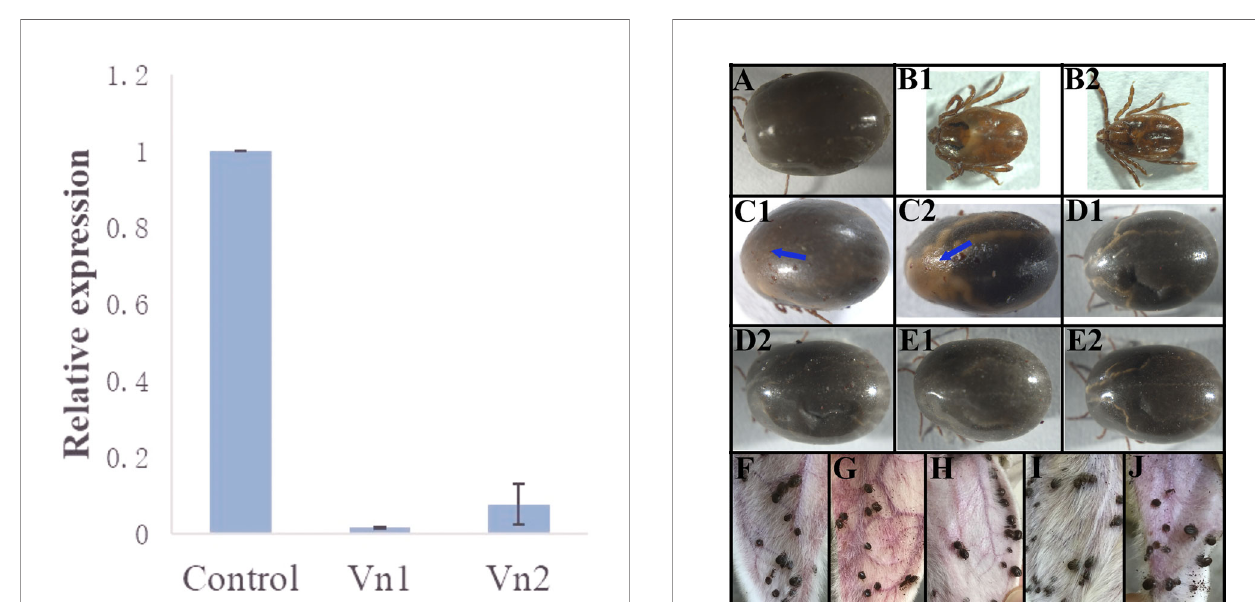
FIGURE 6 | The phenotype associated with actin-depolymerizing factors (ADF), serine/threonine-protein kinase (SPK), Tudor domain-containing protein (TCP), and programmed cell death protein (PD) mRNAs subjected to RNAi in female ticks via injection with the corresponding dsRNAs. (A) Ticks after 7 days of GFP dsRNA injection (control); (B1, B2) Ticks after 7 days of ADF dsRNA injection, note the inability of the ticks to engorge; (C1, C2) Ticks after 7 days of SPK dsRNA injection; note the change in skin colour; (D1, D2) Ticks after 7 days of TCP dsRNA injection (no changes were observed); (E1, E2) Ticks after 7 days of PD dsRNA injection (no changes were observed); (F) Ticks injected with GFP dsRNA (4th day) (control); (G) Ticks injected with ADF dsRNA (4th day), note that they could not engorge; (H) Ticks injected with PD dsRNA (4th day); (I) Ticks injected with SPK dsRNA (4th day); (J) Ticks injected with TCP dsRNA (4th